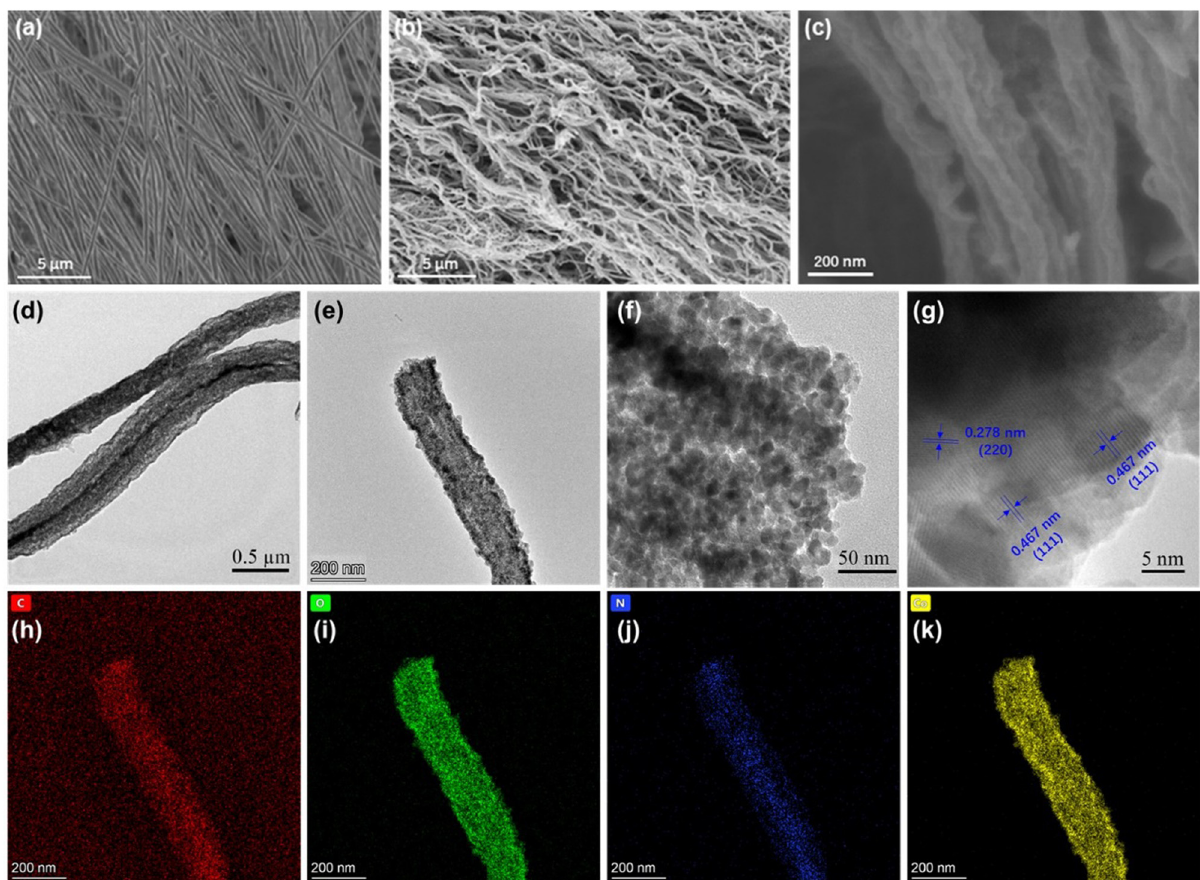
Figure 3: SEM images of oriented ( a ) PAN/Co ( OAc ) 2 and ( b and c ) cPAN/Co 3 O 4 composite fi bers. ( d – g ) TEM images of cPAN/Co 3 O 4 at di ff erent magni fi cations and ( h – k ) the corresponding EDS